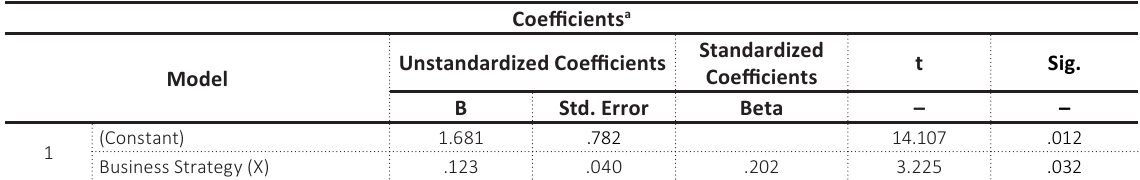
Table 12. T-test for the